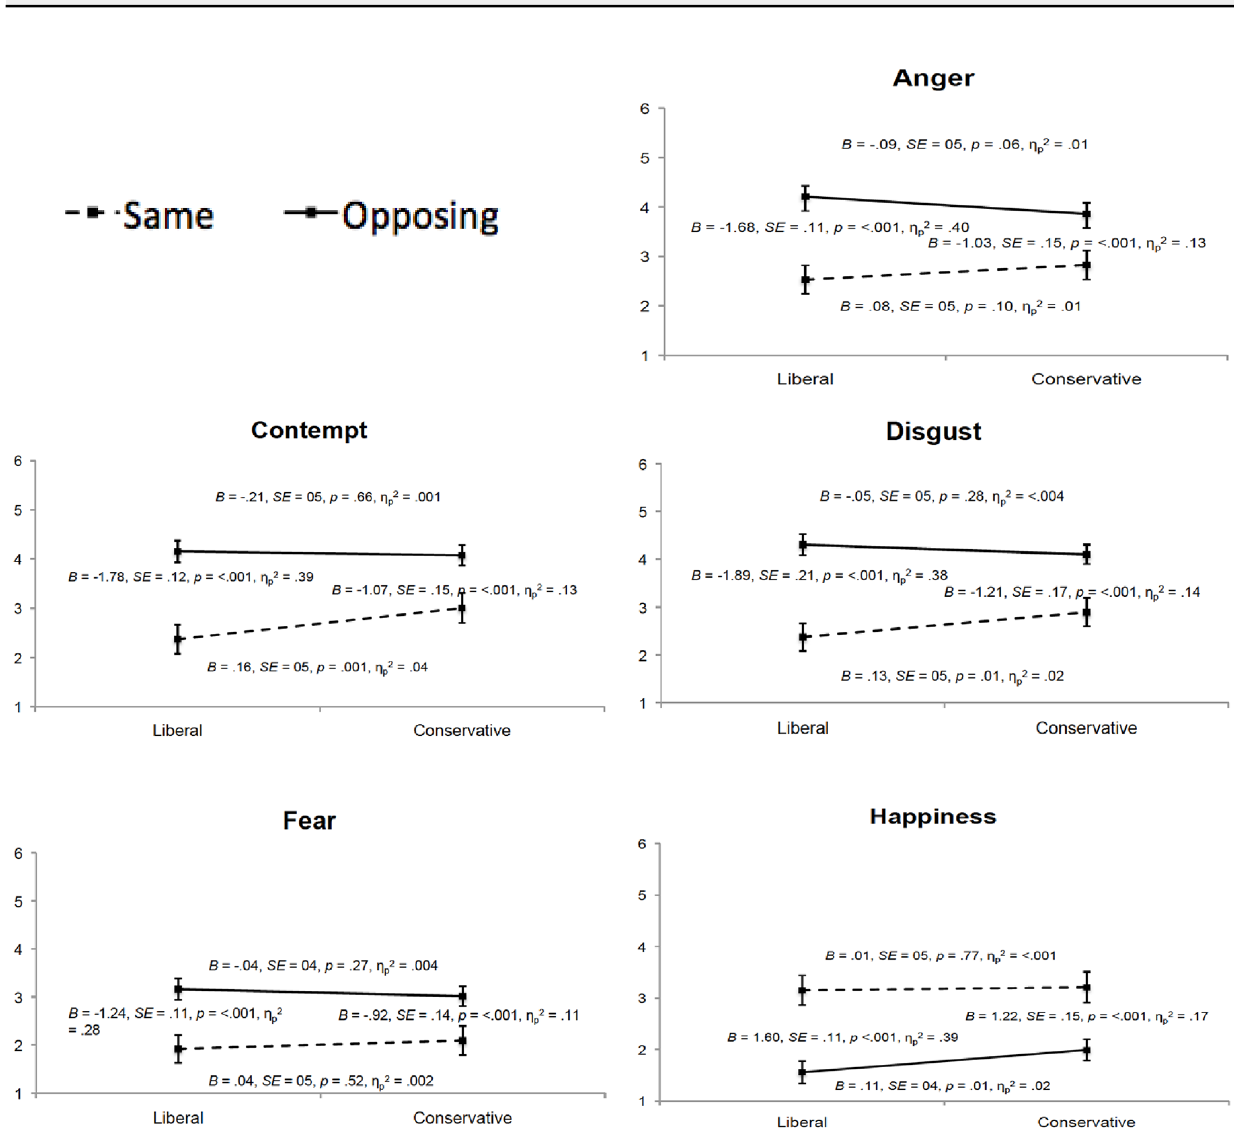
Figure 2. Graphs for Study 2 results. Note. The Liberal and Conservative labels on the horizontal axis represent continuous political